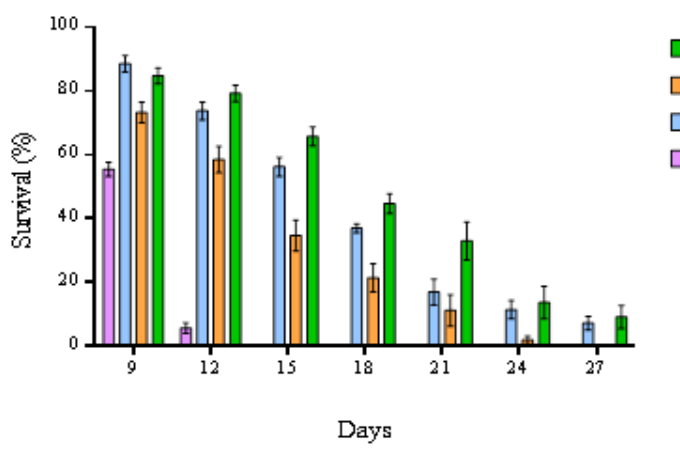
Figure 2. Survival rate (%) of Mesodesma mactroides larvae reared in the laboratory for 27 days and exposed to different salinities (20, 25, 30 and 35 ppt) at a mean (± SD) temperature of 19.4 ± 1.4